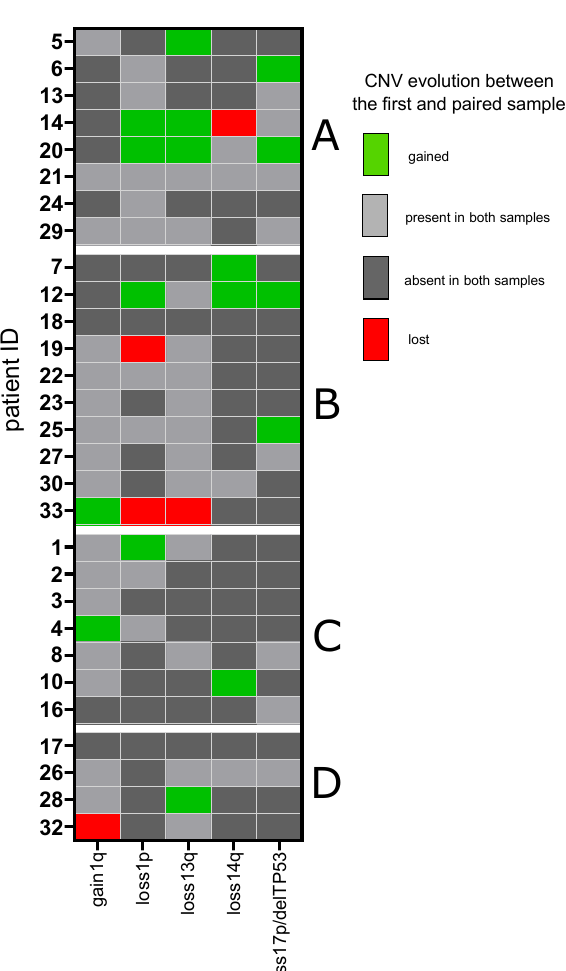
Figure 4. Evolution of copy number variants during multiple myeloma progression based on the next-generation sequencing data from the first and paired samples. Description: A—patients who presented a branching evolution of single-nucleotide variants with mutations lost and gained dur- ing multiple myeloma progression; B—patients who only acquired new single-nucleotide variants during multiple myeloma progression; C—patients who only lost single-nucleotide variants during multiple myeloma progression; D—patients with a stable profile of single-nucleotide variants during multiple myeloma progression.